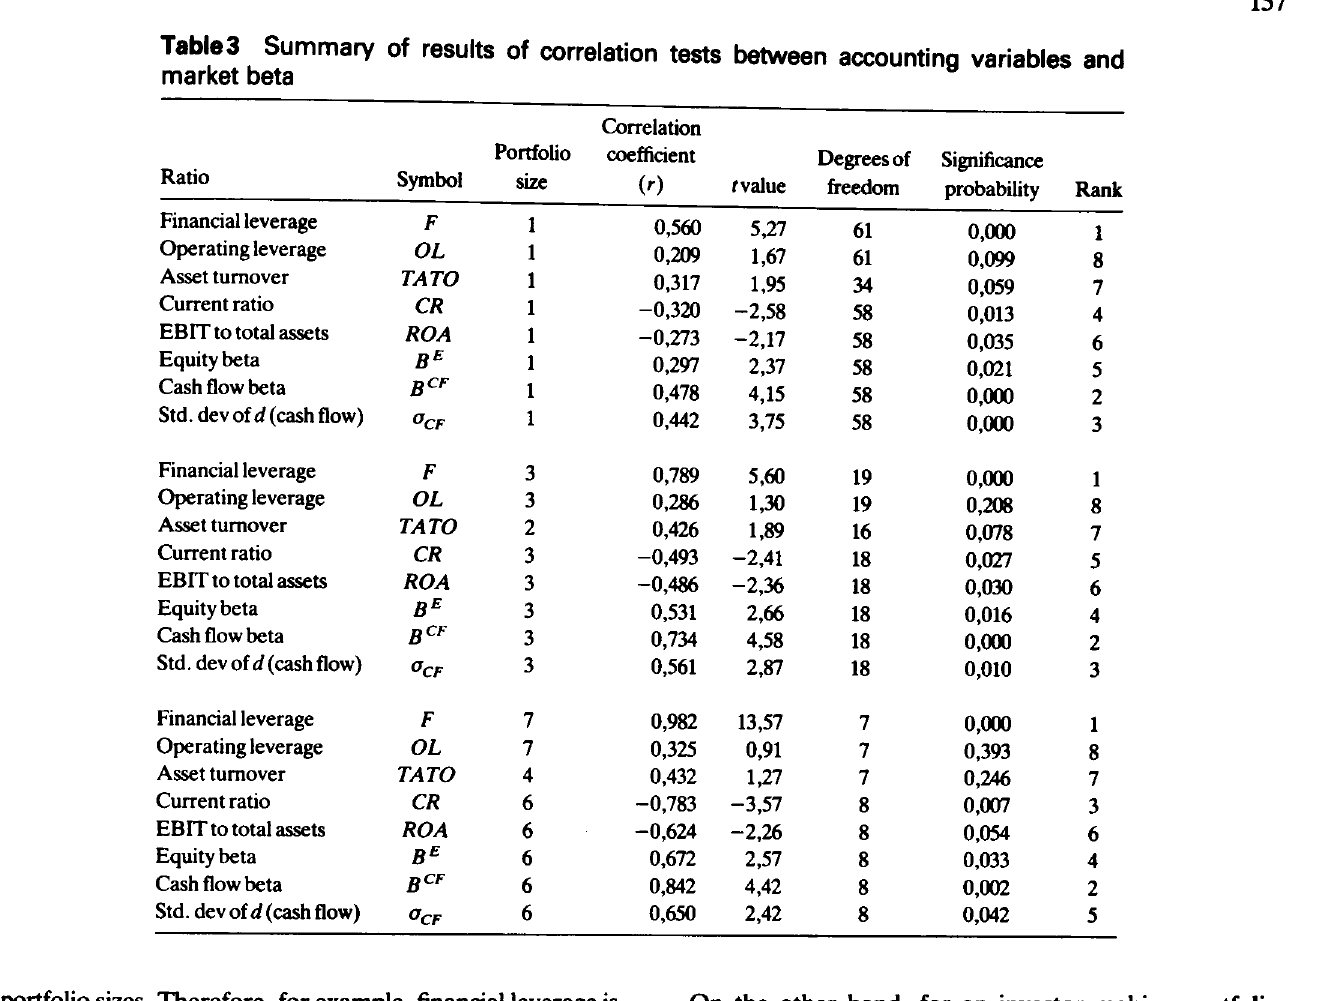
Summary of results of correlation tests between accounting variables and market beta